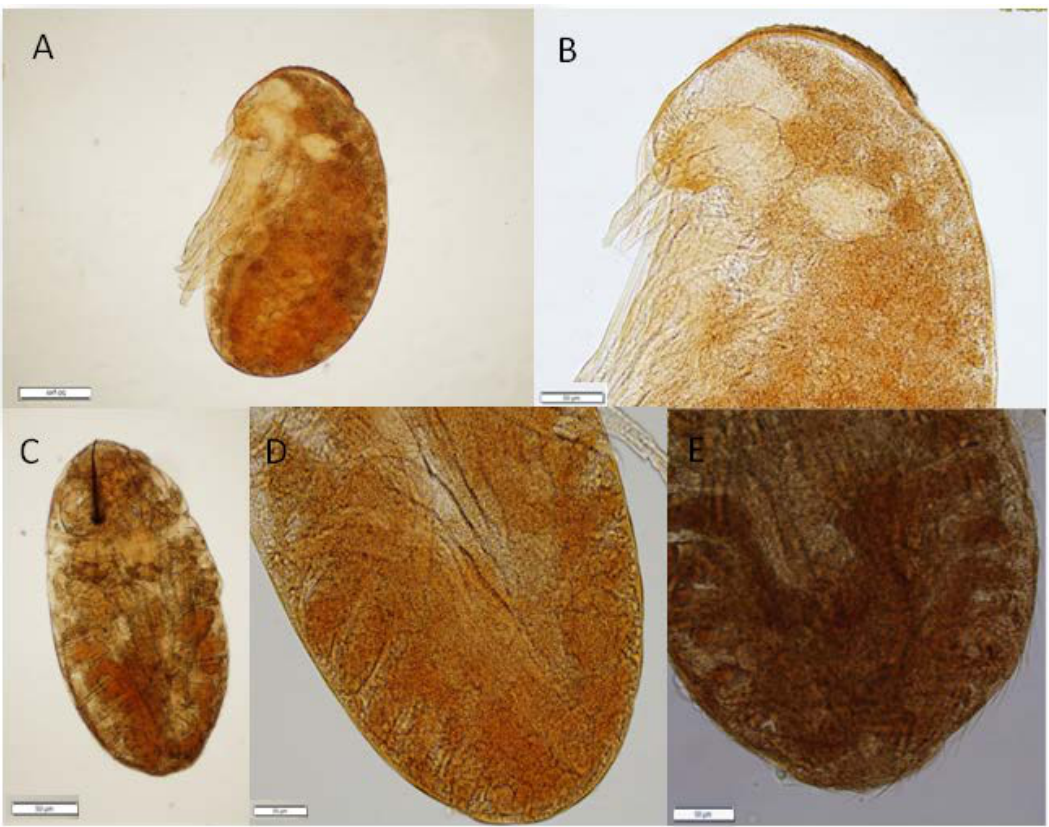
Figure 5. The process of creating a cuticle, egg burster and first hairs of C. cupressi ( A,B,D ) 77 day of development, ( C,E ) 84 day of development. All scale bars are 50 µm long.